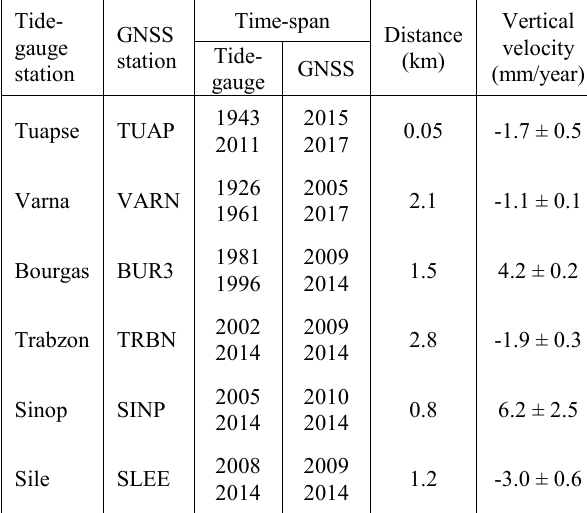
Table 3. Vertical ground motions at the tide-gauge locations along the Black Sea